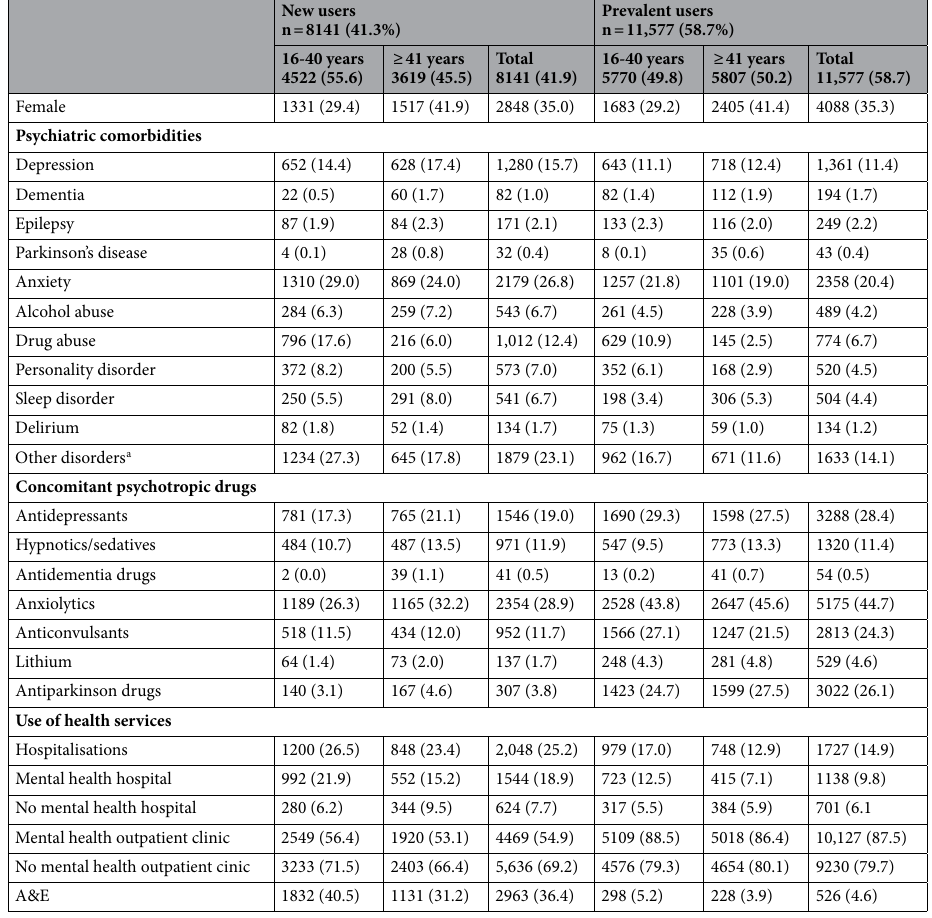
Table 1. Patient characteristics. a Other include: other organic psychosis, bipolar disorder, sexual disorder and acute stress reaction.